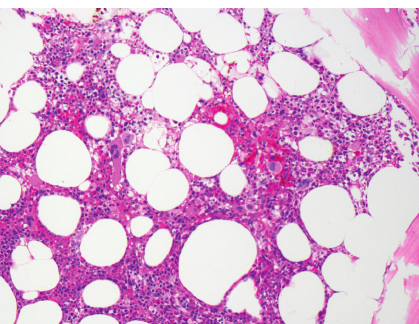
Figure 1: Bone marrow biopsy (200x). The bone marrow is normocellular with adequate trilineage hematopoiesis and normal maturation. Several megakaryocytes are present.